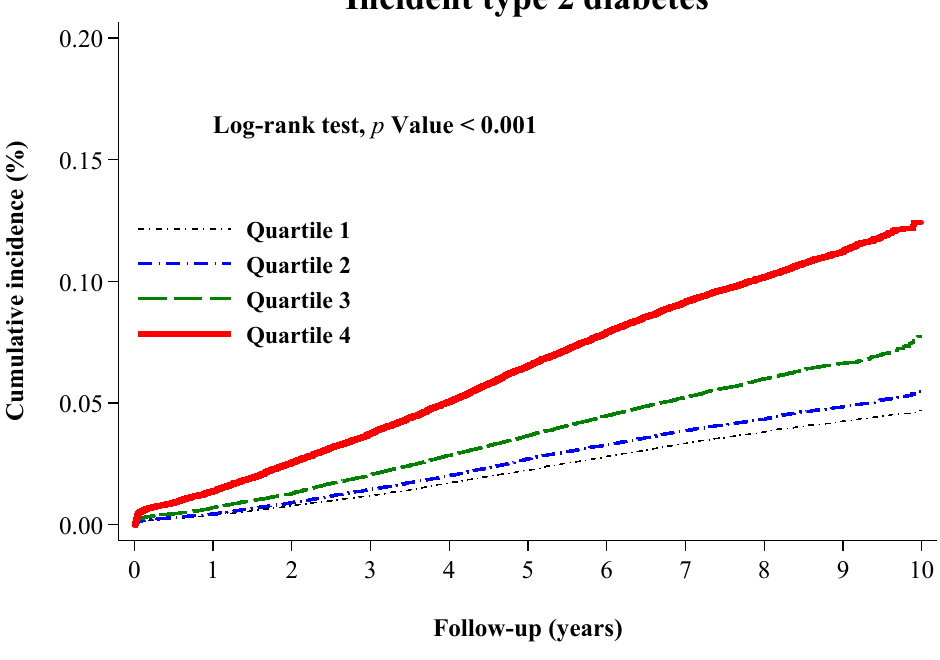
Figure 2. Kaplan–Meier curves showing the adjusted cumulative incidence of type 2 diabetes according to sex-specific quartiles (Q) of serum ferritin: Q1 ( ≤ 90.0 in men; ≤ 25.0 in women) (black dashed line), Q2 (90.1–154.6 in men; 25.1–46.0 in women) (blue dashed line), Q3 (154.7–258.0 in men; 46.1–82.7 in women) (green dashed line), and Q4 ( ≥ 258.1 in men; ≥ 82.8 in women) (red line). p values were for the overall comparison among groups according to the log-rank test.